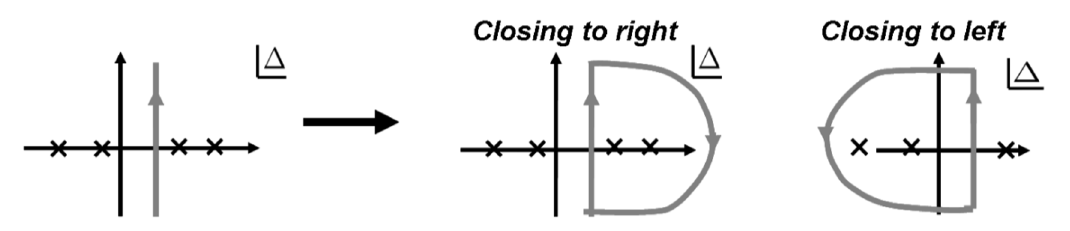
Figure 3 . Left: The original integration contour of the principle series representation. One can close the contour either to the left or to the right, depending on the behaviour of the integrand at j (cid:1) j ! 1 . The integrand has poles on the real (cid:1)